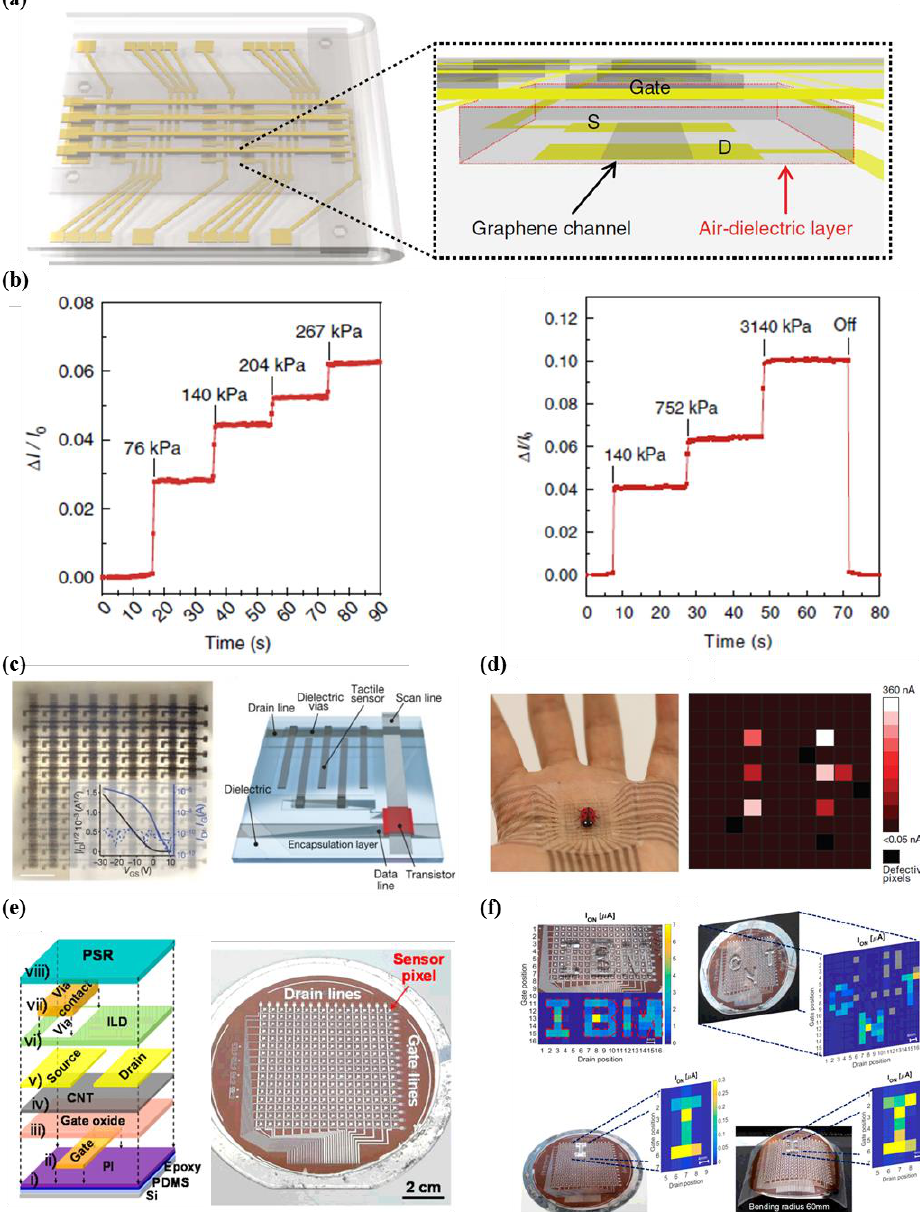
Figure 5. ( a ) Schematic illustration of pressure-sensitive graphene FETs (left). Cross-sectional image unit cell with a graphene channel and an air dielectric layer (right); ( b ) the characteristic of the air dielectric graphene transistors as a function of time at various pressure levels (left: maximum level of 267 kPa, right: maximum level of 3140 kPa) (reprinted with permission for Figure 5a,b from Ref. [52] under CC-BY 4.0 license); ( c ) image of intrinsically stretchable transistor and illustration of unit cell with tactile sensor, electrodes, dielectric, and passivation layer; ( d ) photograph showing the conformal transistor array with ladybug on palm (left), current mapping data resulting from the pressure of the six legs of a ladybug (right) (reprinted with permission for Figure 5c,d from Ref. [58] Copyright 2018 Springer Nature); ( e ) schematic illustration showing fabrication steps of a flexible pressure sensor (left), the photographic image of the active matrix tactile sensor with 16 × 16 array; ( f ) the current mapping data indicating pressure distribution at flat and bending states (radius of 60 mm) (reprinted with permission for Figure 5e,f from Ref. [50] Copyright 2018 American Chemical Society).